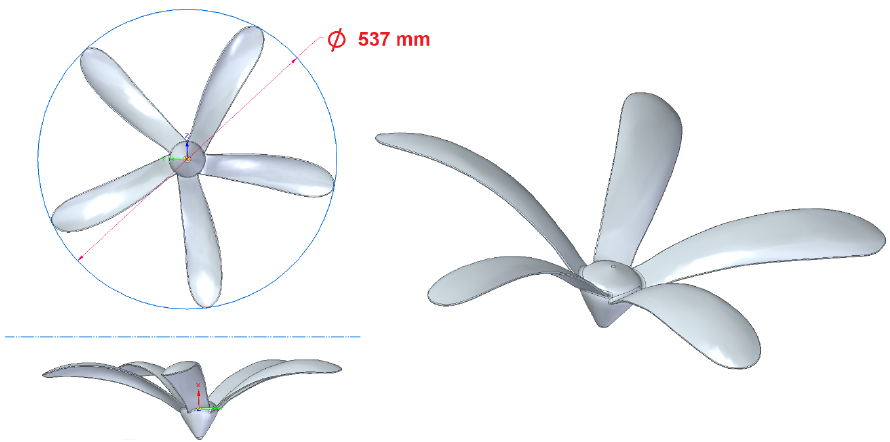
Figure 7. Petrea Volubilis seed computational model.